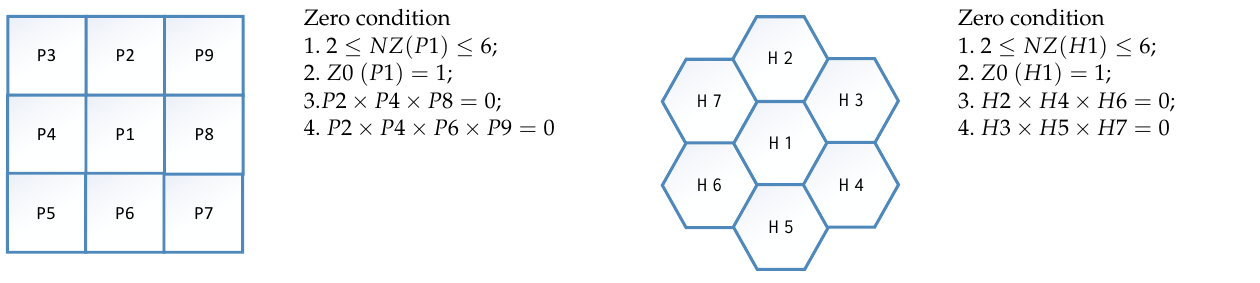
Table 4. Comparison of the refinement zero conditions of rectangular pixels and hexagonal pixels.